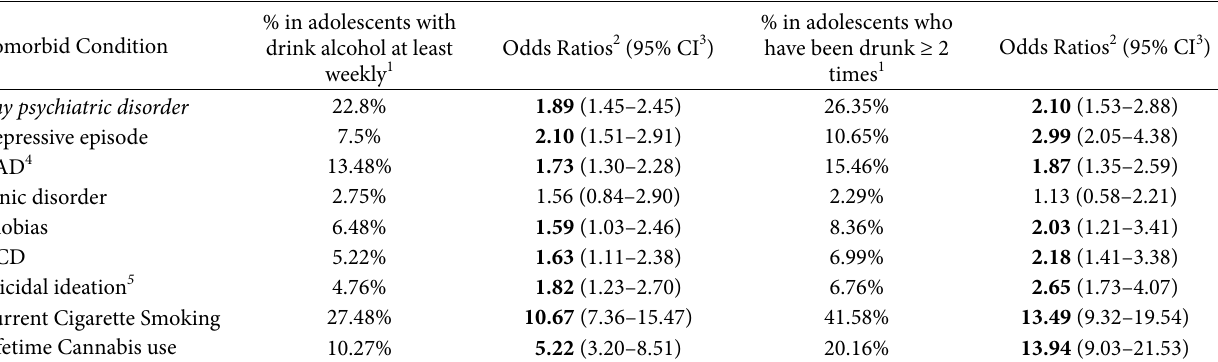
1 All percentages are weighted to account for the stratified random sampling; 2 Odds ratios are adjusted for age and sex and calculated from logistic regression models with the comorbid condition as the dependent variable and the alcohol related variable as the independent variable (e.g., the odds of any psychiatric disorder was 1.89 times higher for adolescents who drink alcohol weekly compared to participants who do not drink alcohol weekly); 3 CI: Confidence Intervals ; 4 GAD: General- ized Anxiety Disorder; 5 Suicidal ideation defined as having at least thoughts that “life is not worth living” during the past week. Table 4: Use of health services use among 16–18 year-old adolescents with frequent alcohol drinking and getting drunk ( 𝑁 = 2431 ).